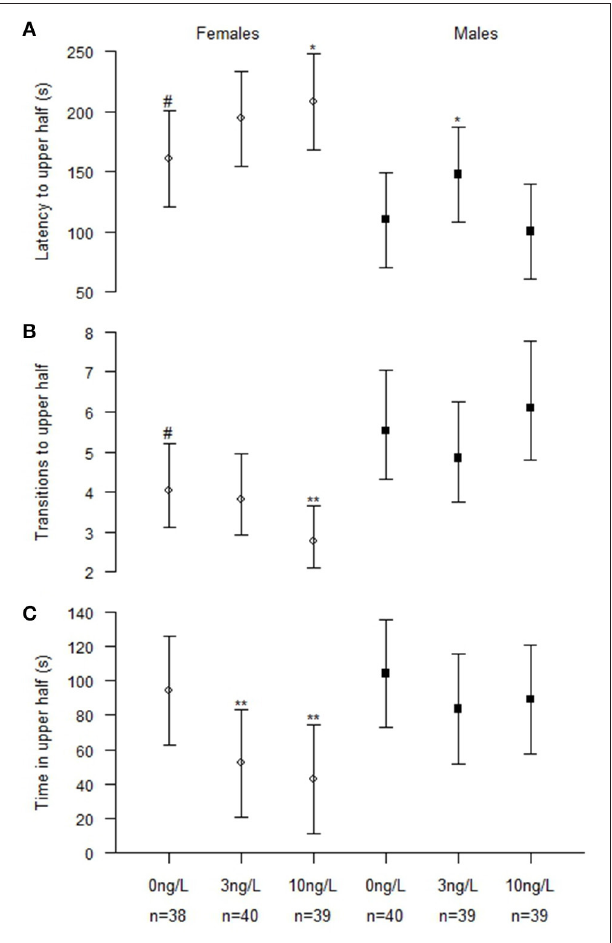
FIGURE 1 | Novel tank behavior in male and female zebrafish developmentally exposed to 0, 3, or 10ng/L EE 2 and remediated in clean water for 120 days. (A) Latency time before crossing the horizontal midline to the upper half. (B) Number of transitions to upper half and (C) Total time spent in upper half. Data represent mean ± 95% CI, # p < 0.05, * p < 0.05, ** p < 0.01. *Significantly different from control fishes of the same sex, # control females significantly different from control